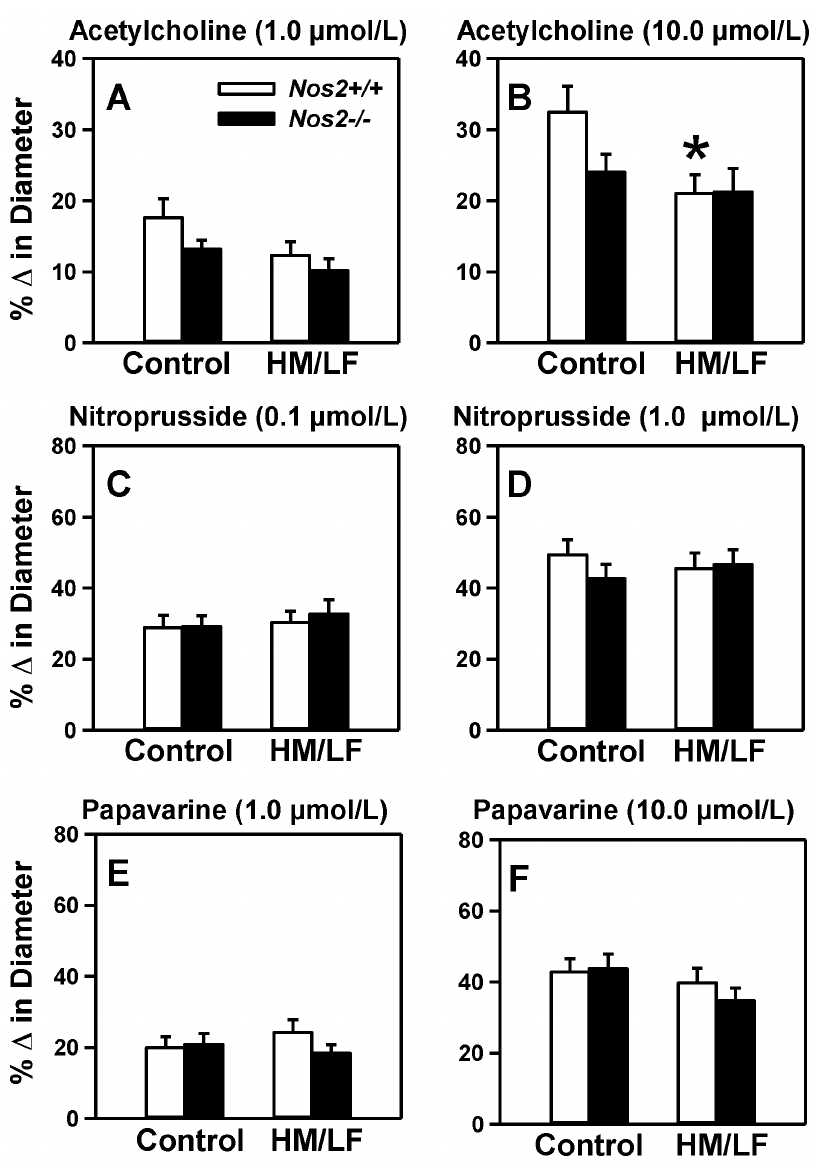
Figure 2. Dilator responses in cerebral arterioles. Dilatation of cerebral arterioles to (A) 1.0 m mol/L acetylcholine, (B) 10.0 m mol/L acetylcholine, (C) 0.1 m mol/L nitroprusside, (D) 1.0 m mol/L nitroprusside, (E) 1.0 m mol/L papaverine and (F) 10.0 m mol/L papaverine were measured in Nos2 + / + (open bars) or Nos2 2 / 2 (filed bars) mice. 10–15 mice were studied in each group. *P , 0.05 compared with mice of same genotype fed the control diet by two-way ANOVA.